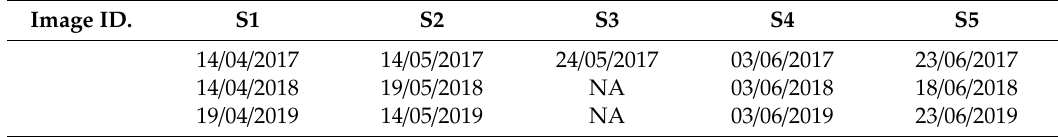
Table 2. List of the satellite images used in this study (NA = not available). Image ID.